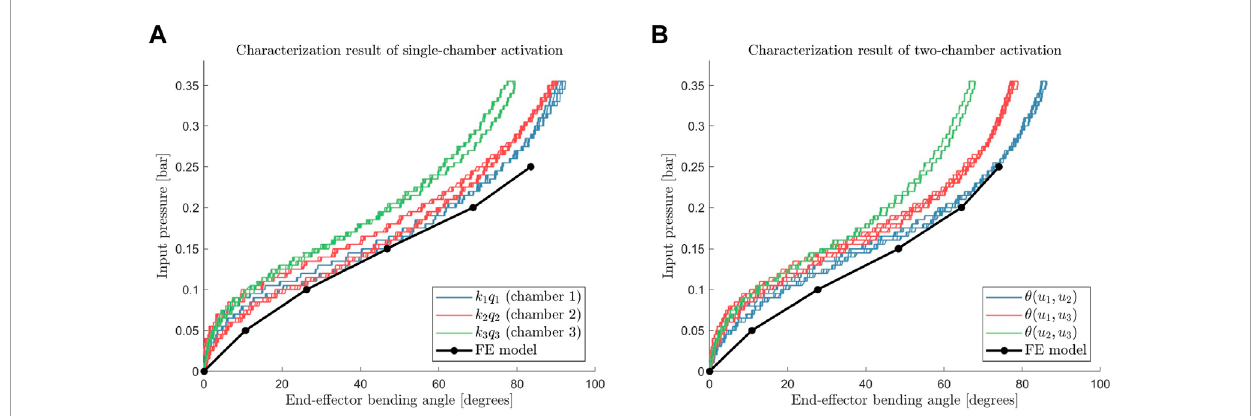
FIGURE 5 Angle to input pressure relation at steady-state when only single actuation chamber is pressurized (A) , and two actuation chambers are pressurized simultaneously (B) along with each finite element model outputs.